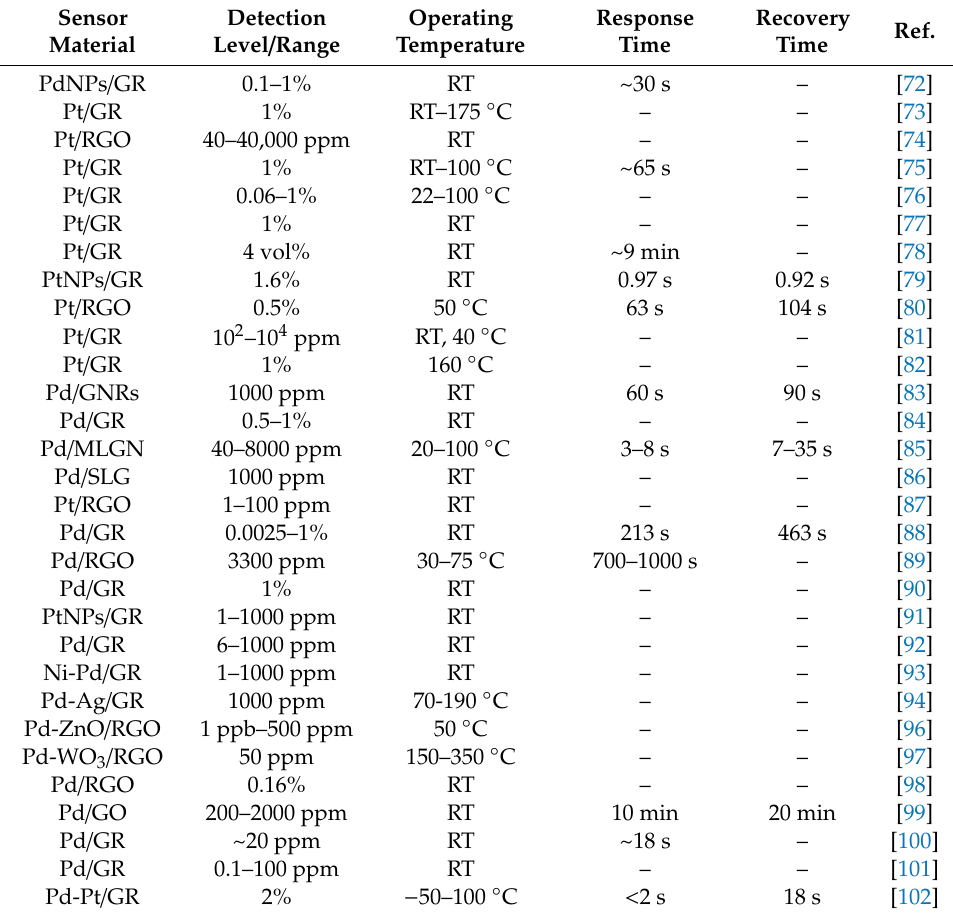
Table 2. Comparison of the H 2 sensors based on graphene and their composites with